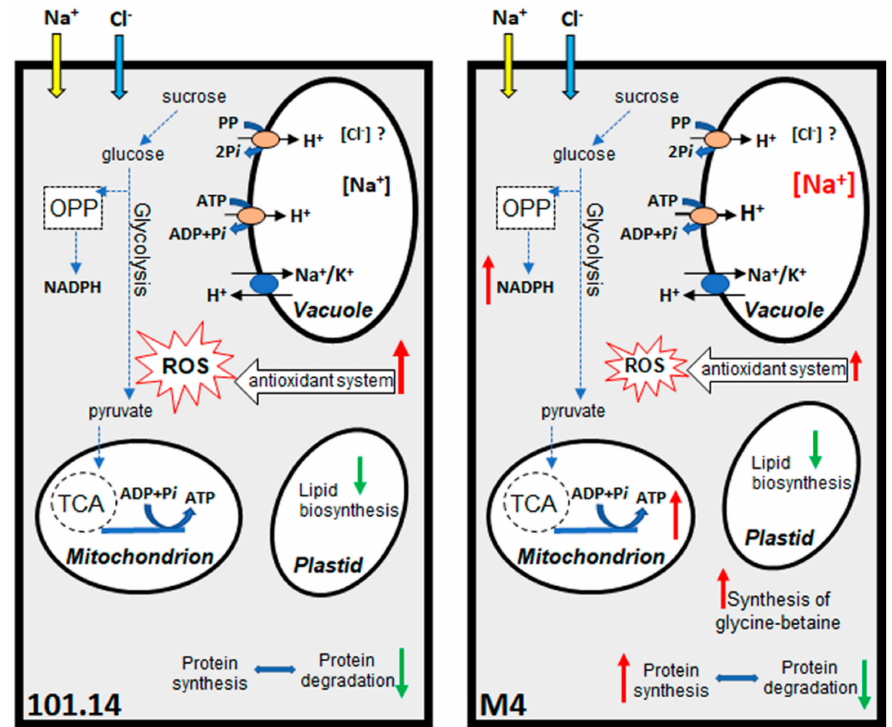
Figure 5. Schematic overview summarizing the main di ff erences between 101.14 and M4 genotypes in biochemical processes highlighted by the proteomic analysis. Red arrows indicate an increase while green arrows indicate a decrease in the